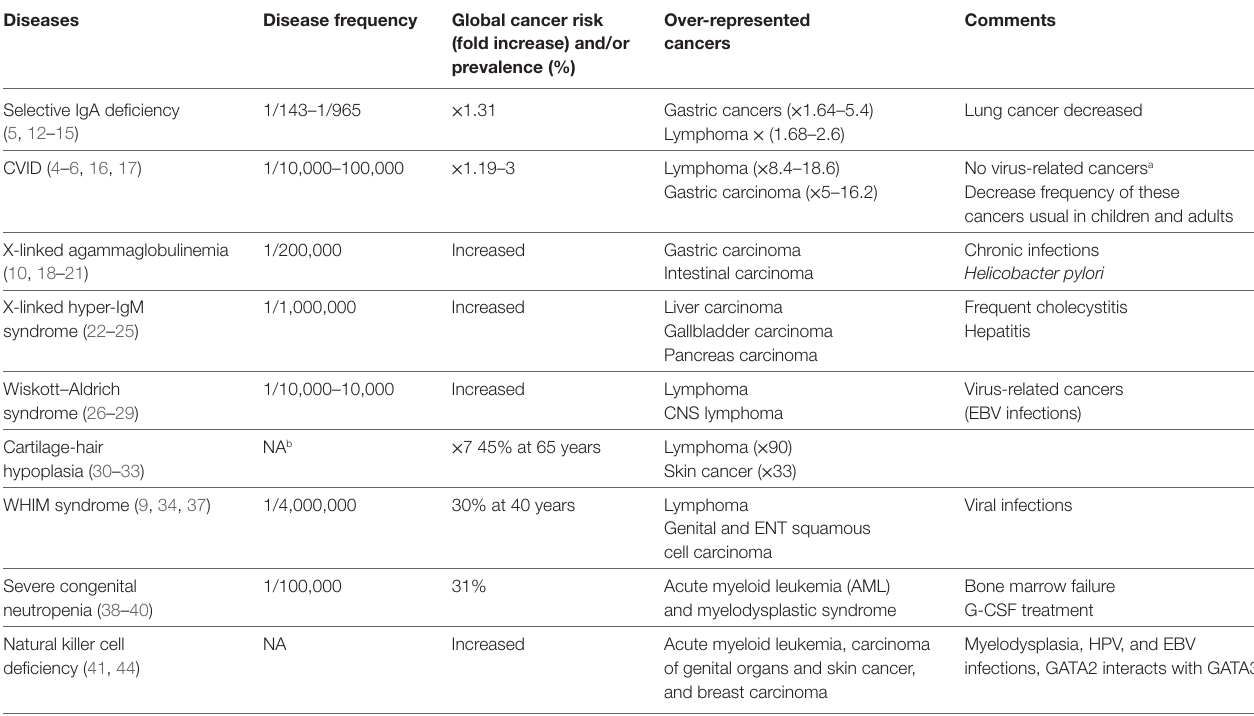
TAble 1 | Frequency of nine inherited diseases with primary immune deficiency and their cancer risk.